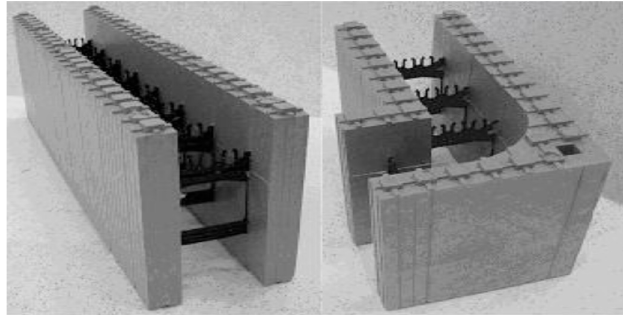
Fig. 3. The permanent thermo insulated casing.